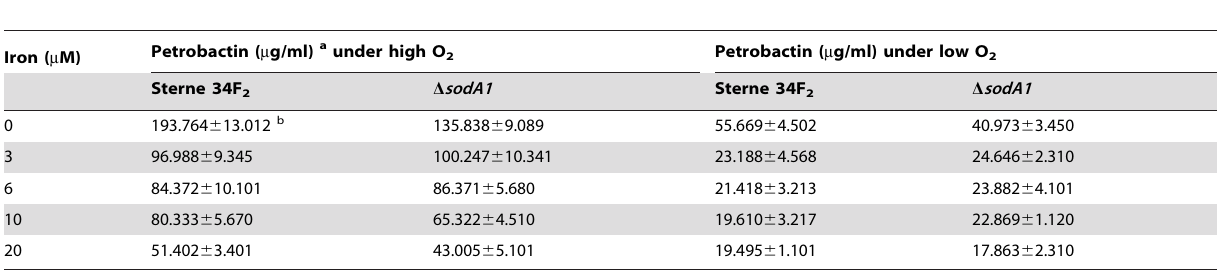
Table 3. Quantification of petrobactin from IDM cultures of Bacillus anthracis Sterne 34F 2 and D sodA1 with the addition of different concentrations of iron under high (high O 2 ) and low aeration (low O 2